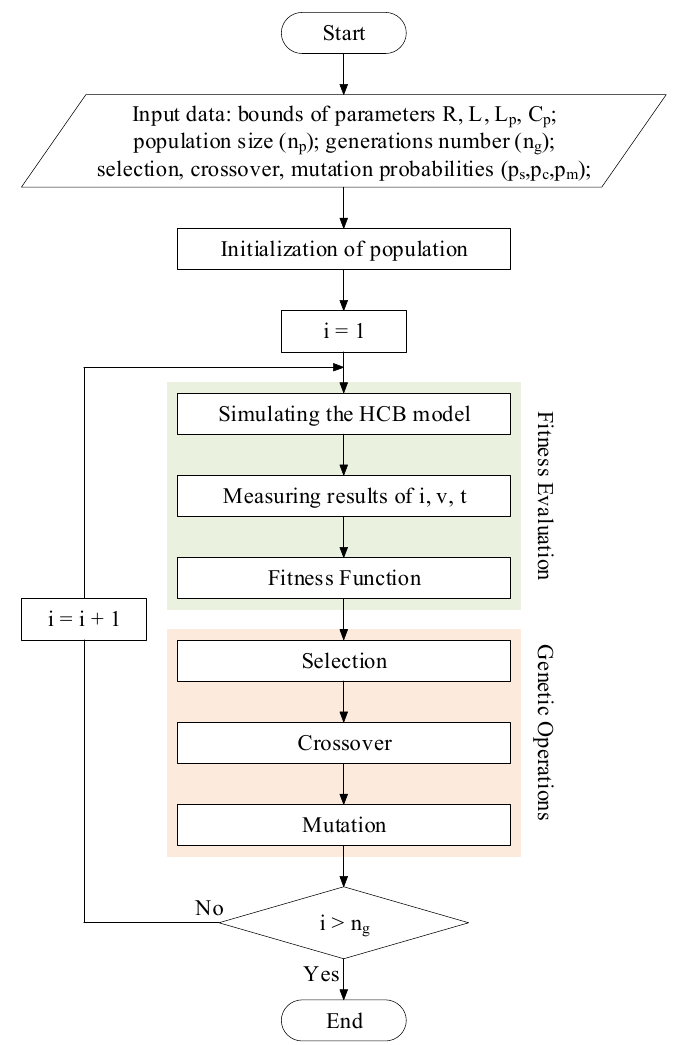
Figure 3. Flowchart of the proposed MOGA for optimizing parameters in the